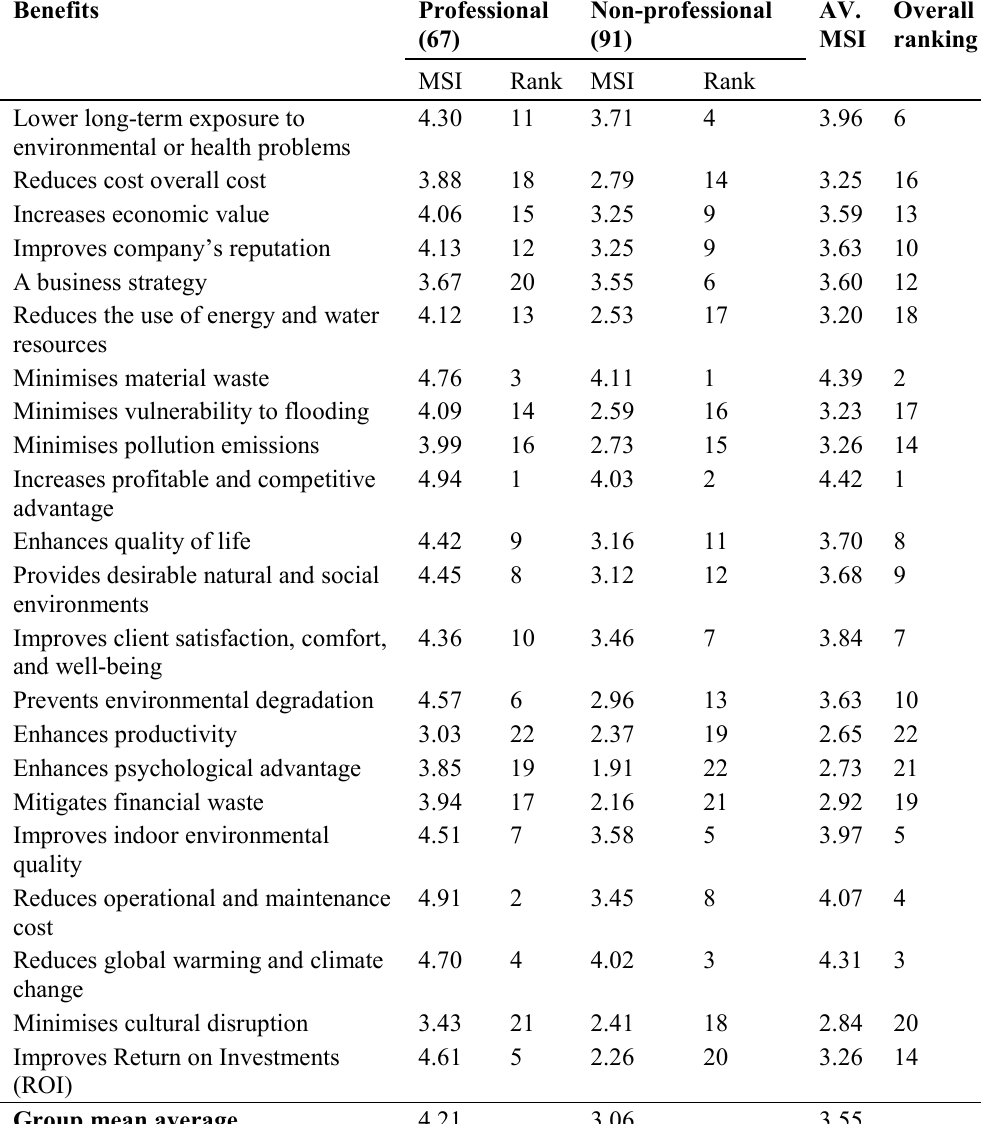
Table 3. Level of Awareness of Benefits of Sustainable Construction